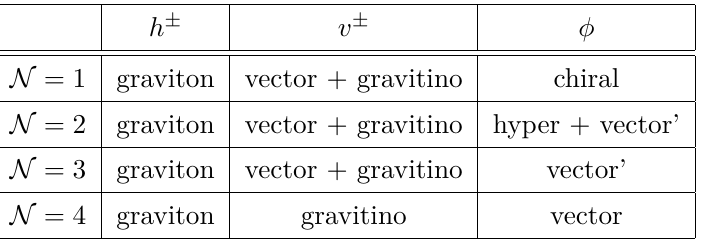
Table 3. Massless supermultiplets containing the tensor h , vector v and scalar (Galileon) φ modes of the massive graviton in the high-energy limit. In some cases + is used to denote a possible admixture, when representation theory is insufficient to identify a unique multiplet. The notation vector / vector’ is used to distinguish distinct massless vector